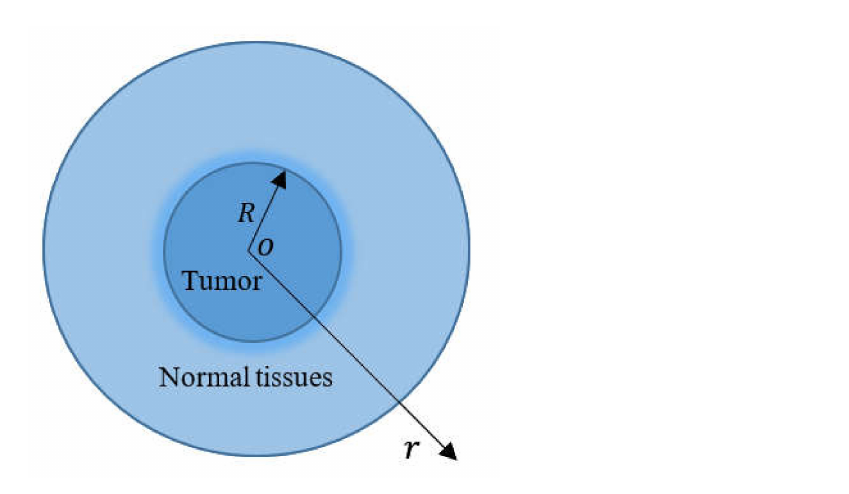
Figure 1. Model of a spherical tumor with a radius R implanted in normal tissue. The Pennes bioheat equation in the tumor and normal tissues with constant physio- logical parameters can be stated as